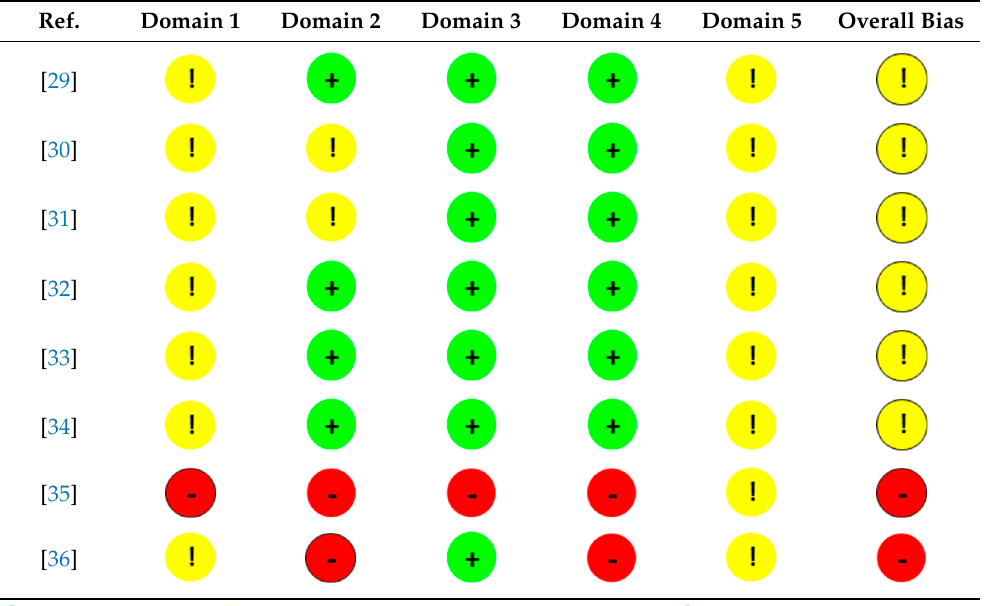
—Low risk of bias; —Some concerns associated with risk of bias —High risk of bias; Do- mains: 1—arising from the randomization process; 2—deviations from the intended interventions; 3—missing outcome data; 4—measurement of the outcome; 5—selection of the reported result.